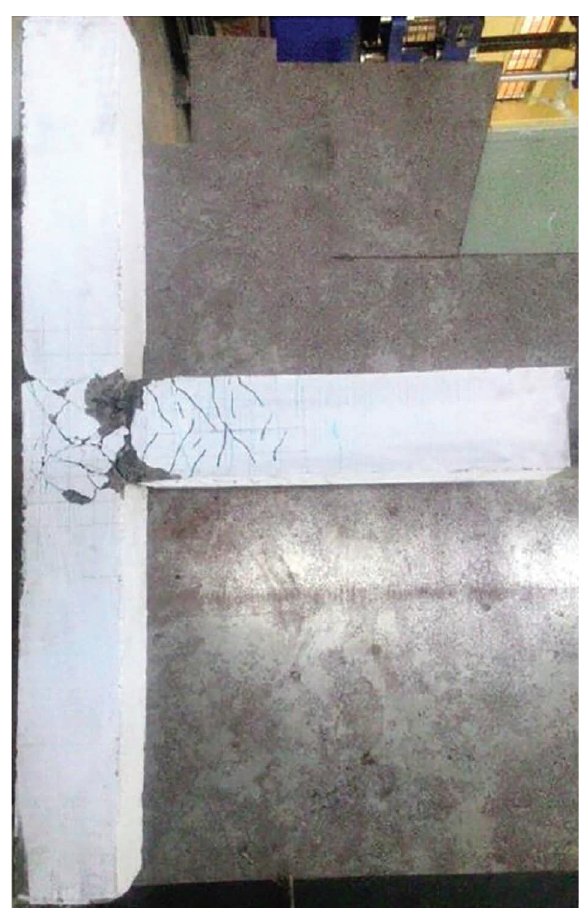
Figure 6: Fracture patterns of Alccofne